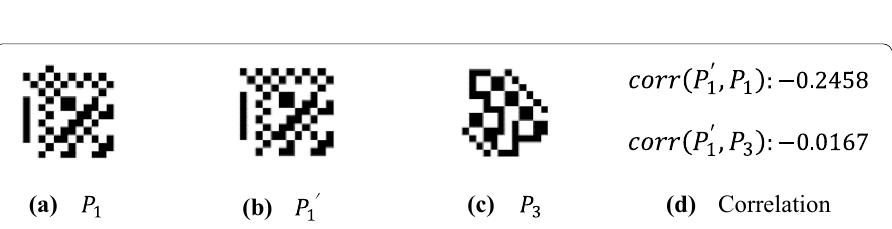
Fig. 3 Two texture patterns, one shifted version, and their correlation values. a Texture pattern P 1 , b Upper-shifted version of pattern P 1 , c Texture pattern P 3 , d Correlation